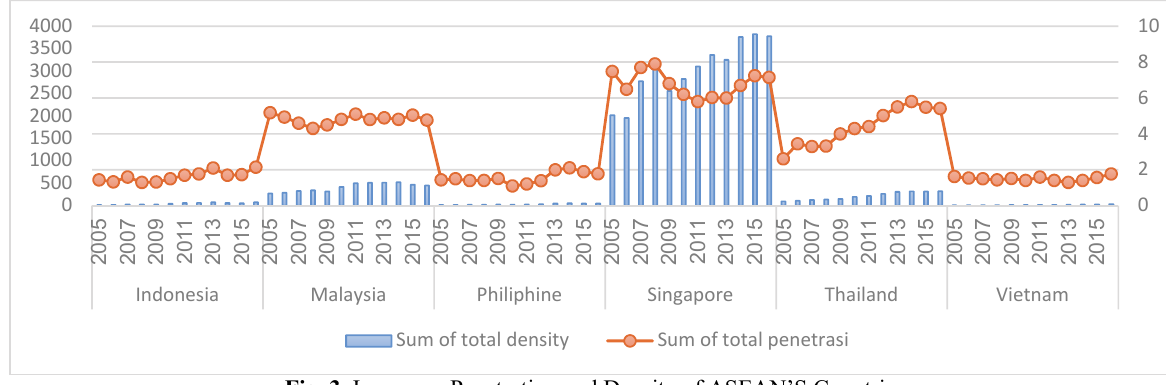
Fig. 3. Insurance Penetration and Density of ASEAN’S